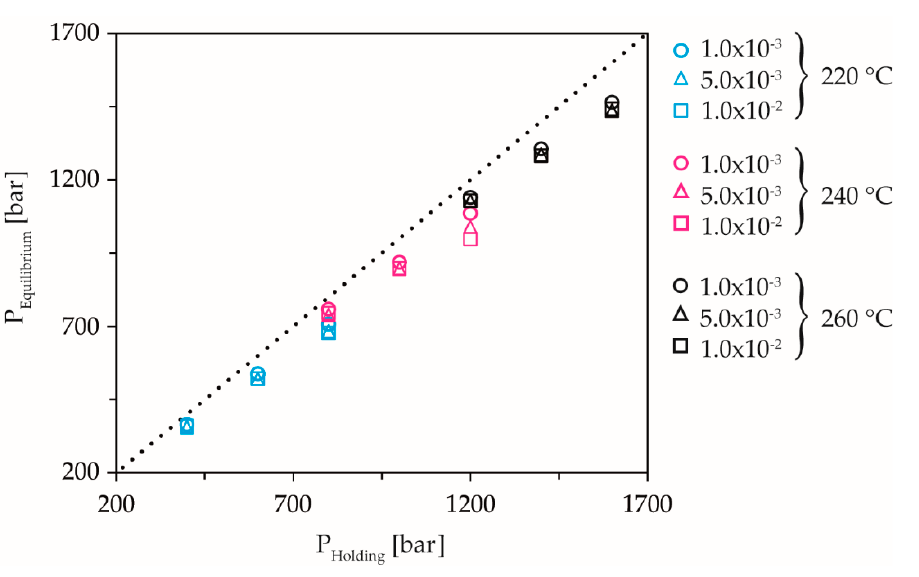
Figure 9. Equilibrium pressure as a function of holding pressure, temperature, and compression rate.